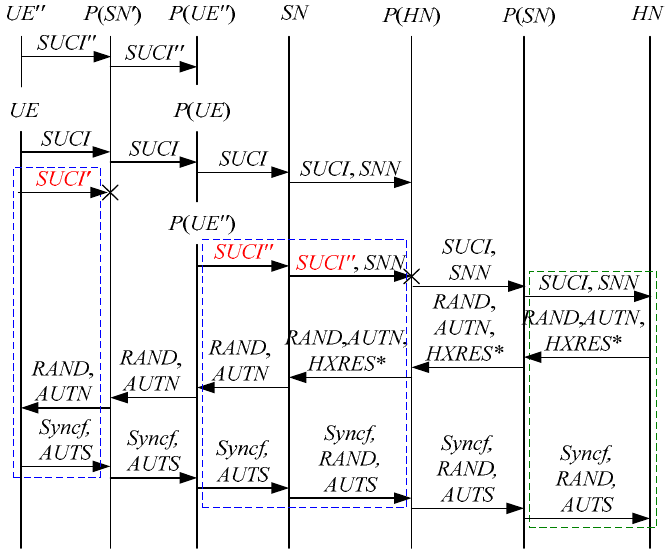
Figure 13. The twelfth attack scenario of the 5G AKA protocol. In Figure 13, the green dashed box represents the server strand of Theorem 5, while the blue dashed boxes represent the initiator strand and the responder strand of Theorem 5. The fields marked in red on the initiator strand and the responder strand are some fields that cannot be agreed with the HN, which are caused by MitM attacks.